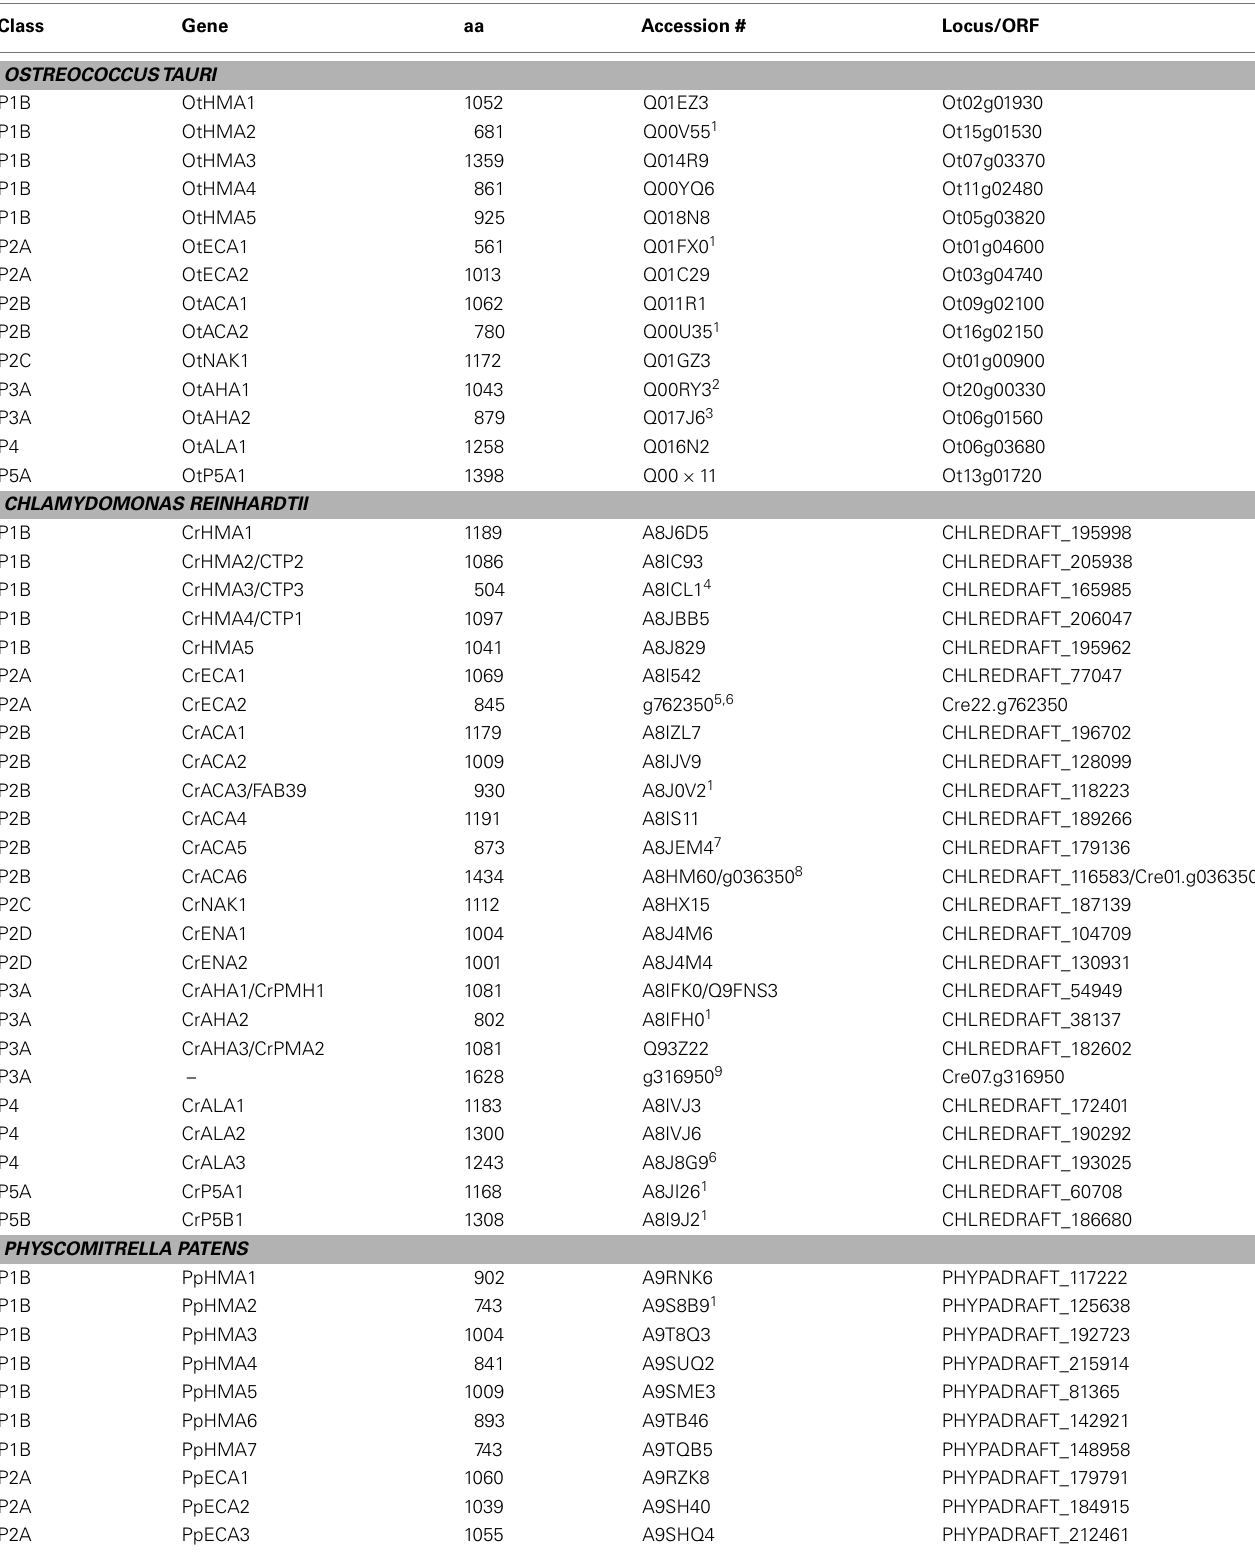
Table 2 | List of P-typeATPases analyzed in this